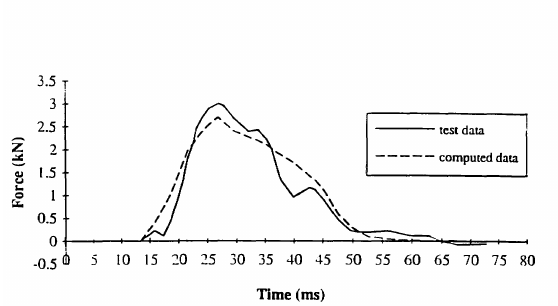
FIGURE 11 The flow pattern at an instant during the inflator discharge for aspirated system.